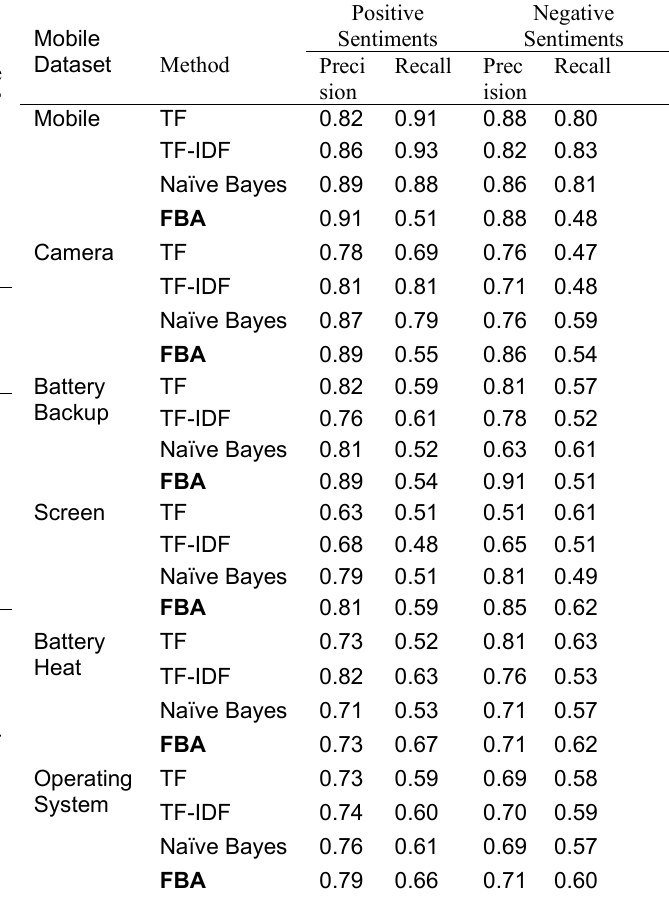
Table 7. Performance evaluation of FBA with TF,